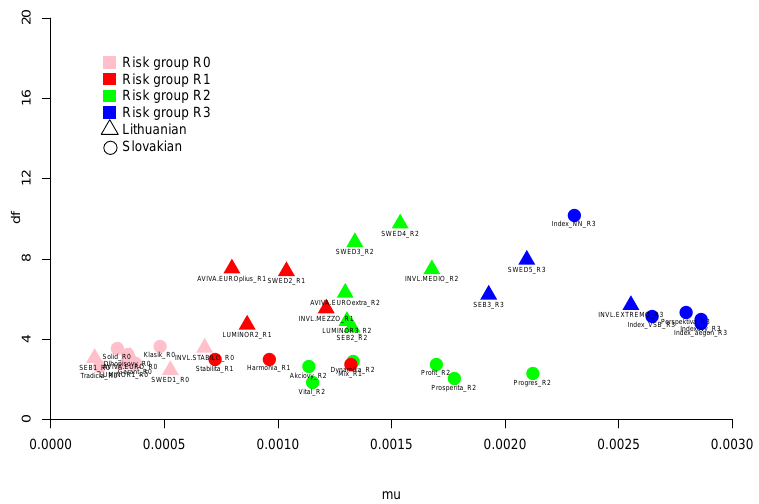
Figure 4. Scatter plot of estimates of location and degrees of freedom parameters of scaled student- t distribution for Slovak and Lithuanian pension